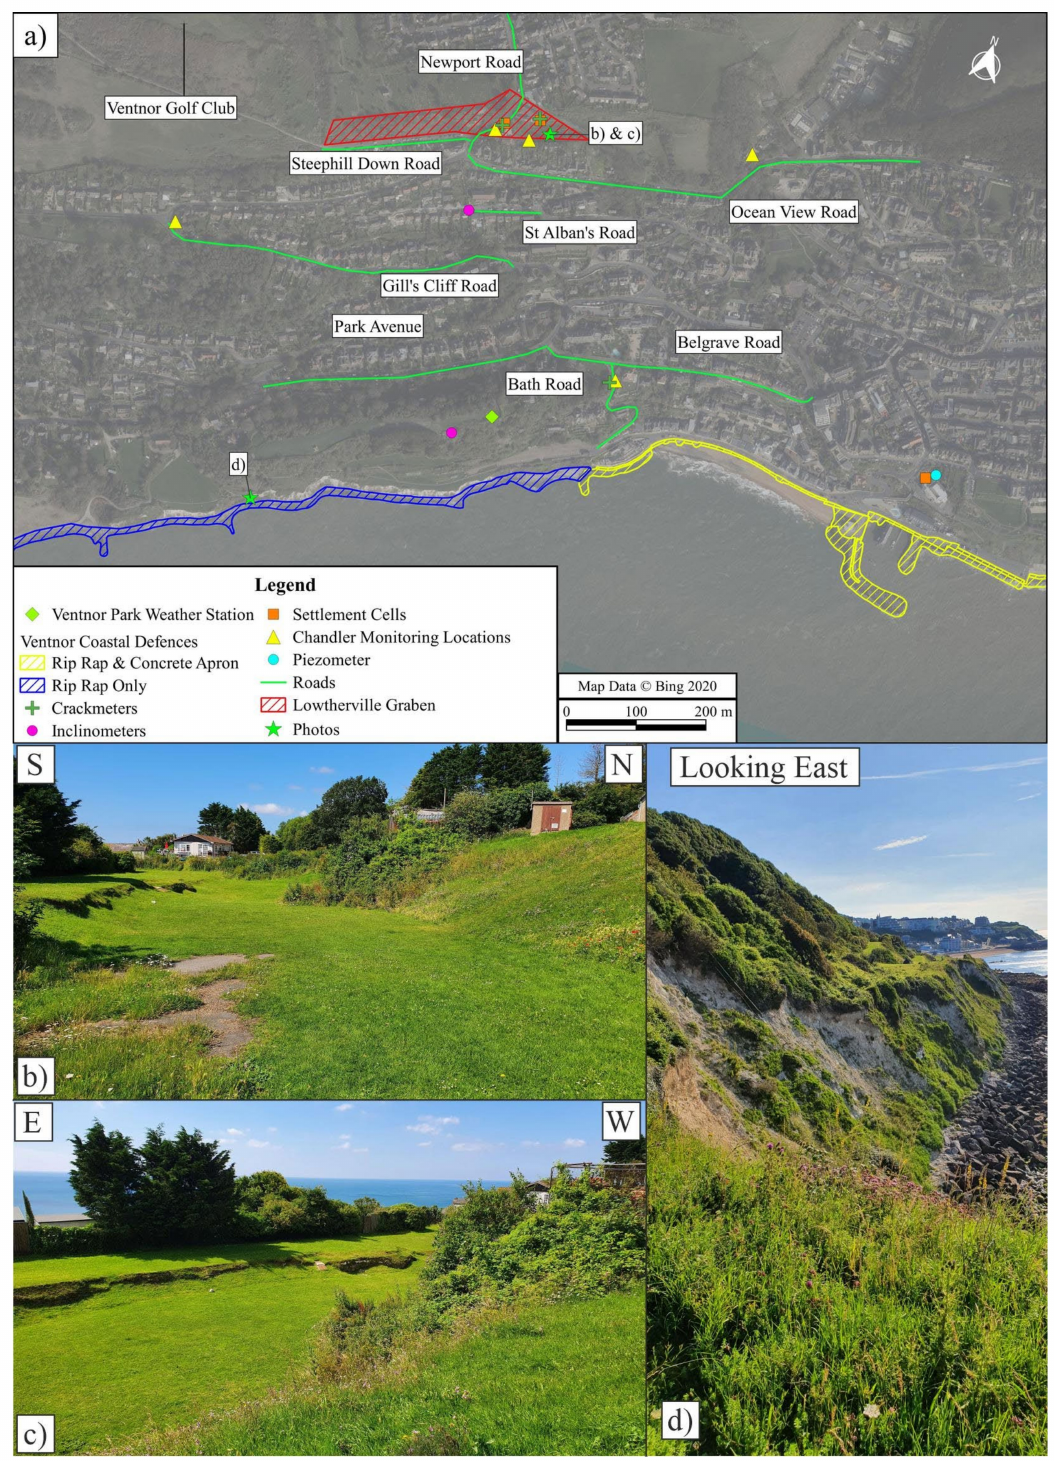
Figure 3. ( a – d ): Instrumentation locations at Ventnor, after Chandler [28], Geomorphological Services Limited [29], and Moore et al. [30] ( a ). Image shows the transition between rip rap and/or the concrete apron and rip rap only along the coastline. Image ( b , c ) shows ongoing movement at the Lowtherville Graben, showing settlement in the middle of the Graben that creates ca. 8 m tall berm to the north and 0.5 m to the south. Image ( d ) shows the toe of the landslide, with a rock apron present along the shoreline. The steep angle of the chalk cliff demonstrates the active erosion at the site. Image ( a ) created on QGIS with background imagery from Bing Maps